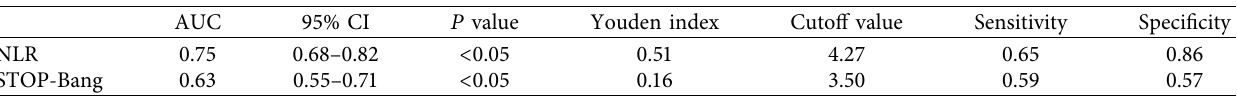
Table 5: Diagnostic accuracy of NLR and STOP-Bang questionnaire in predicting OSA in AD patients (groups A and C) with the best cutoff value.